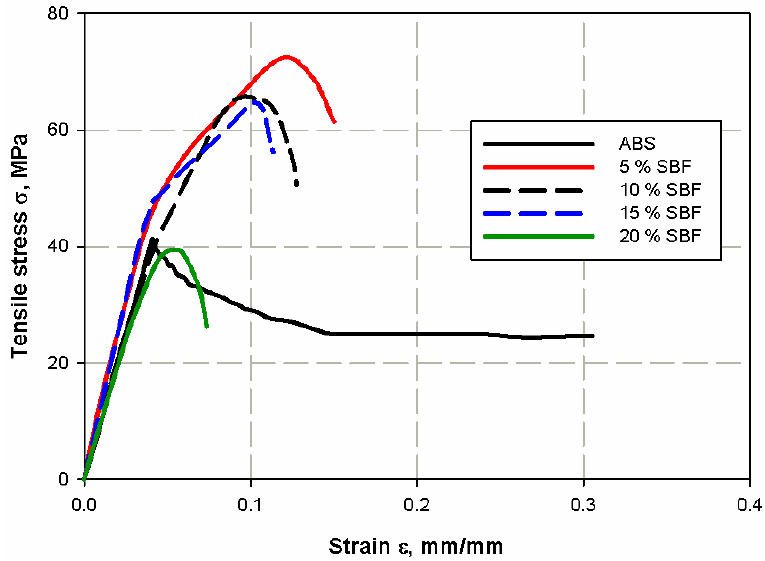
Figure 3. Stress–strain diagram for short basalt fiber (SBF)-reinforced acrylonitrile–butadiene–styrene (ABS).